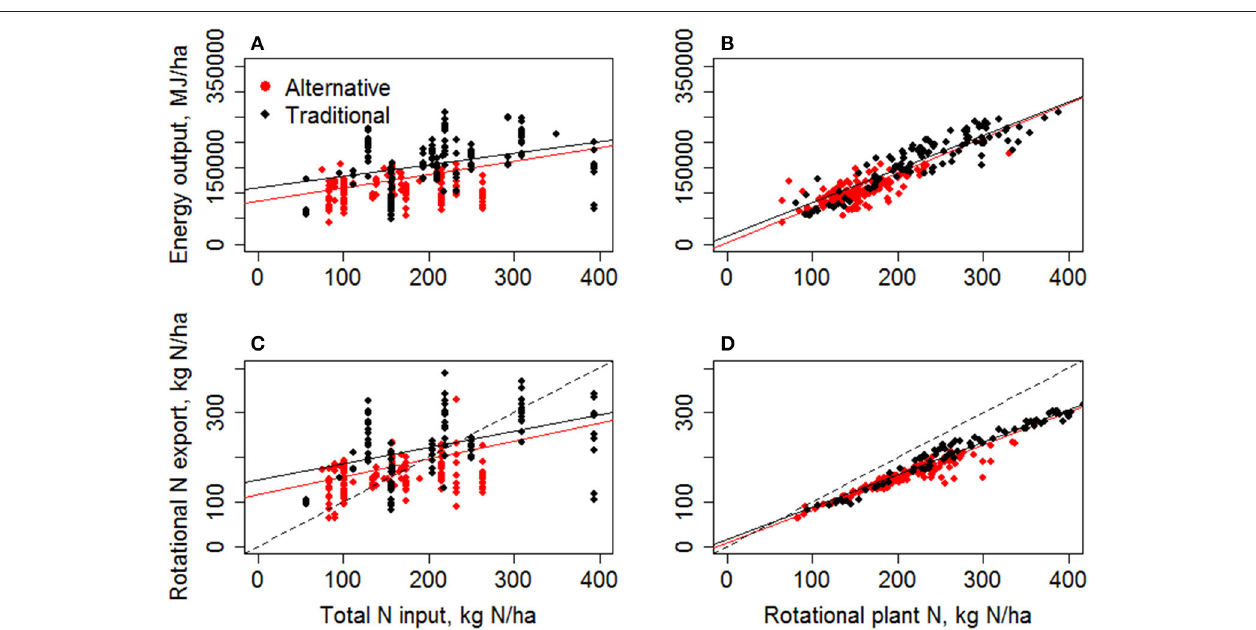
FIGURE 8 | Rotational nitrogen use efficiency of cropping systems in the inland PNW from 2011 to 2016, including (A) the response of rotational energy outputs to total fertilizer N additions, (B) the rotational utilization efficiency of grain N to produce energy, (C) ratio of rotational grain N export to total fertilizer N additions, and (D) rotational N harvest index. Traditional rotations include WW-summer fallow and WW-CF rotations at Ralston, Moro, and Ritzville, and WW-SW-CF at Davenport and all rotations listed in Table 2 . Alternative rotations replaced WW-F through a reduction or elimination of fallow when precipitation was < 350 mm yr − 1 . Broken line represents the 1:1